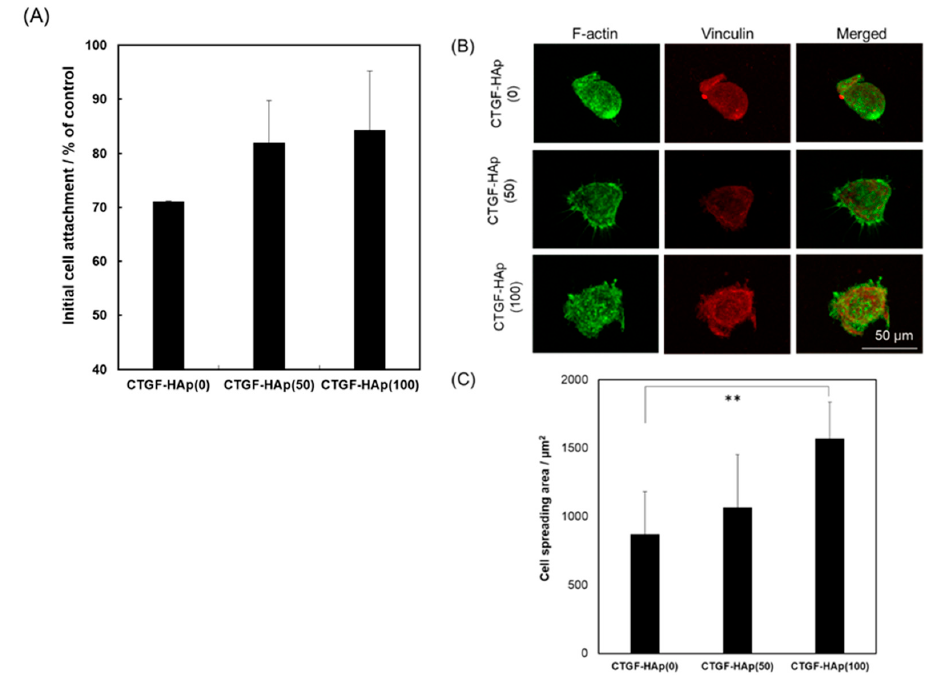
Figure 1. Effect of connective tissue growth factor (CTGF) on cellular attachment and morphology at 5 h after seeding. ( A ) Initial cell attachment as a percentage of the tissue culture plate. CTGF-HAp(100) ceramic has the highest percentage of the attached cell. Cell attachment increased with CTGF, though there were no significant differences among them. ( B ) Fluorescence images of MC3T3-E1 cells on CTGF-HAp ceramics at 5 h. Actin filaments were stained with Alexa Fluor ® 488-labeled phalloidin (green), and vinculin was stained with monoclonal anti-vinculin (red). Scale bar indicates 50 μ m. ( C ) Cell spreading was quantified by measuring the area of cells from fluorescent images of cells. Bar graphs represent means ± SD (n = 13). ** Significantly different ( p < 0.001) from the value with CTGF- HAp(0).